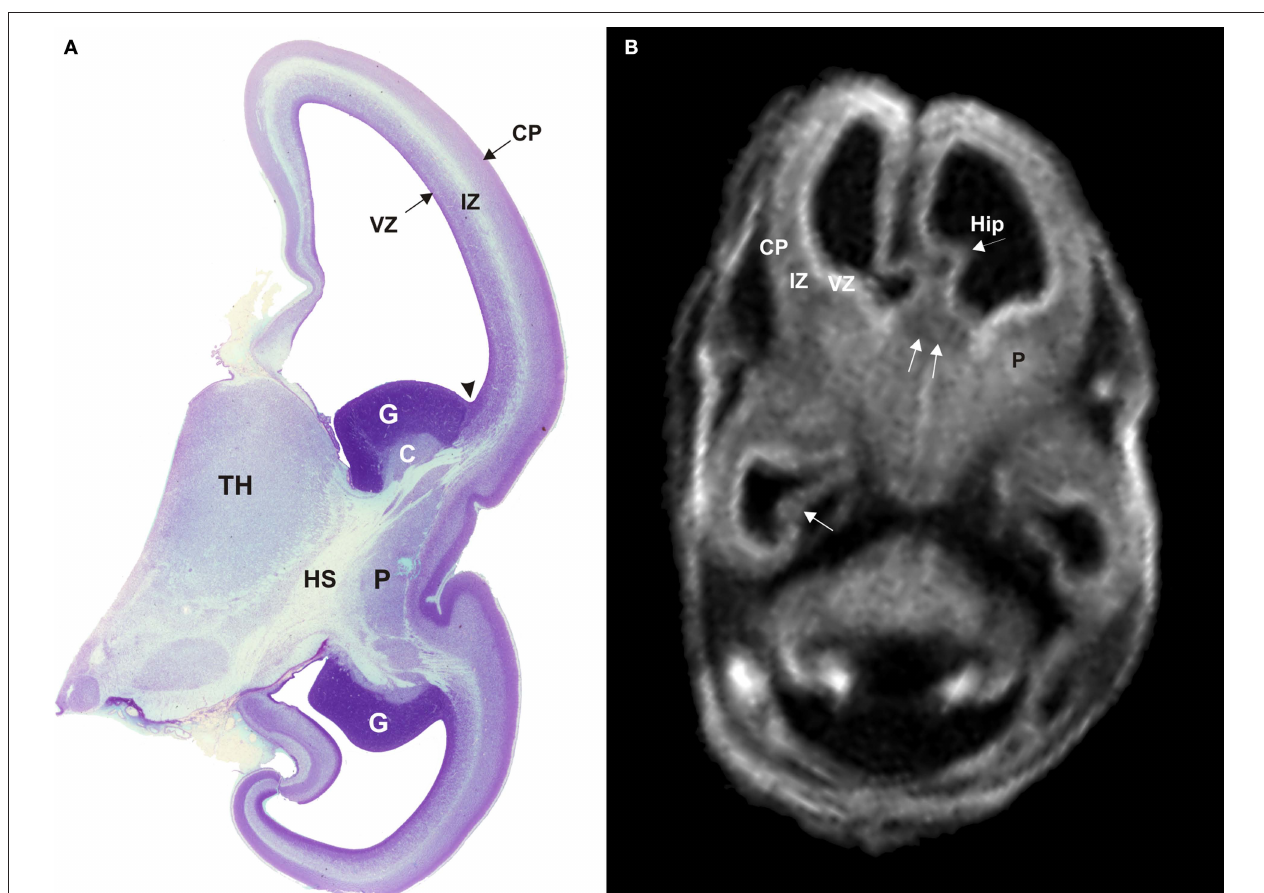
FIGURE 1 | Semi-horizontal Nissl-stained slide (A) and T1-weighted MRI slice (B) through the fetal telencephalon at 11.5 PCW (A) and 12.5 PCW (B). The cerebral wall consists of the ventricular zone (VZ), the intermediate zone (IZ) and the cortical plate (CP). Trilaminar organization of the cerebral wall, the ganglionic eminence with developing caudate and putamen, and the hippocampal anlage (arrowhead Hip) are all clearly visible on both histological and